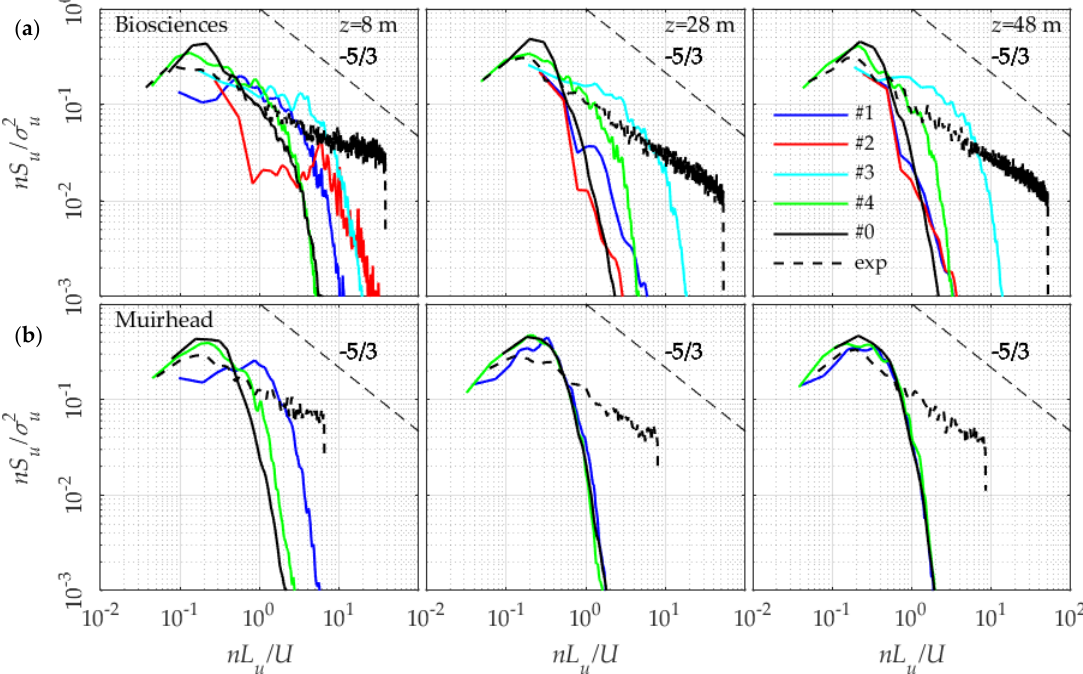
Figure 13. Power Spectral Density of the wind speed at several heights above the Muirhead tower ( a ) and Biosciences tower ( b ).